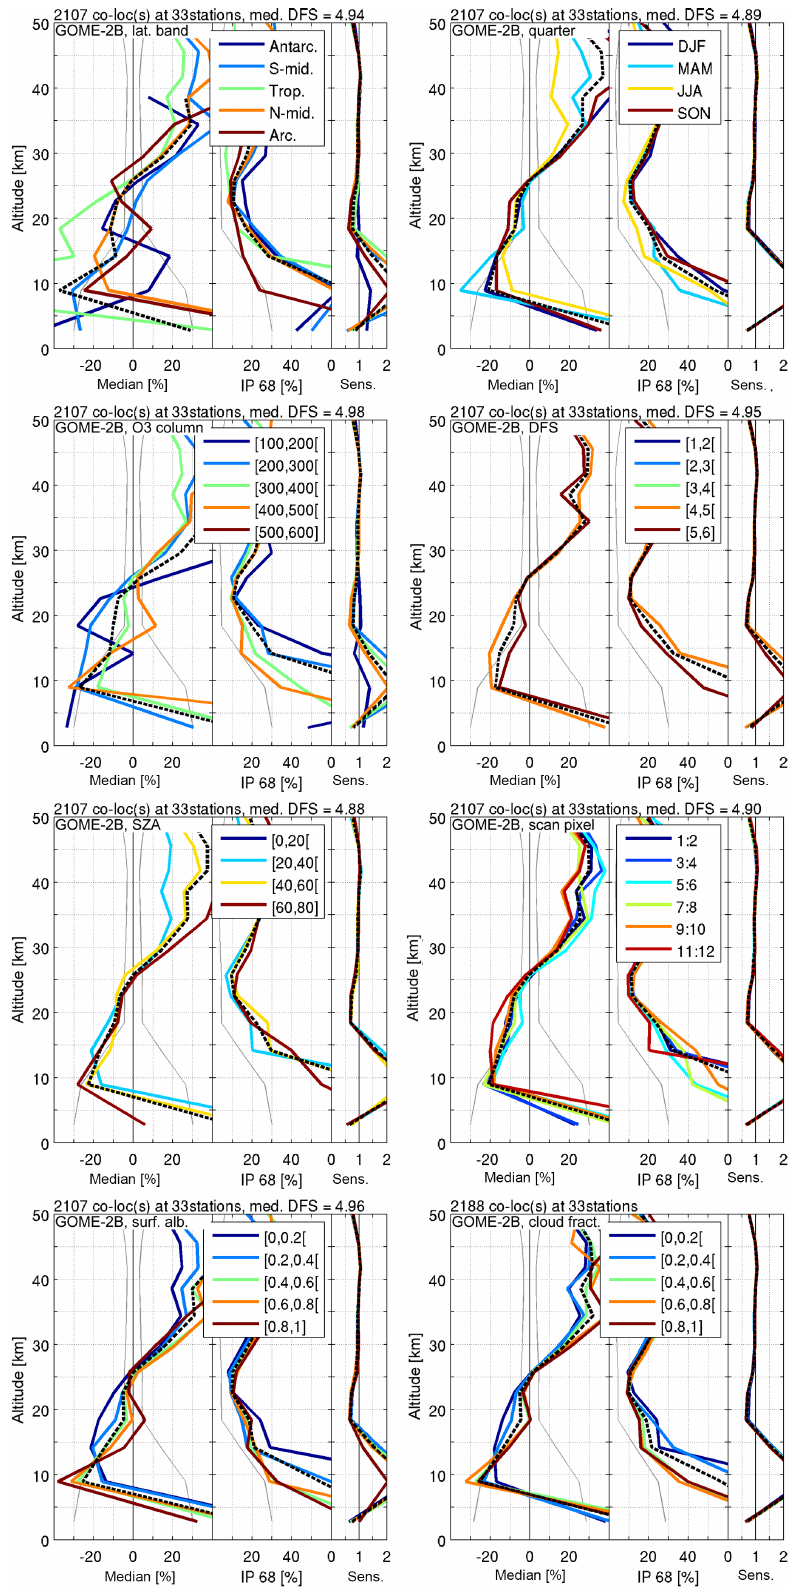
Figure 9. As for Fig. 6, but for RAL v2.14 L2 GOME-2B data